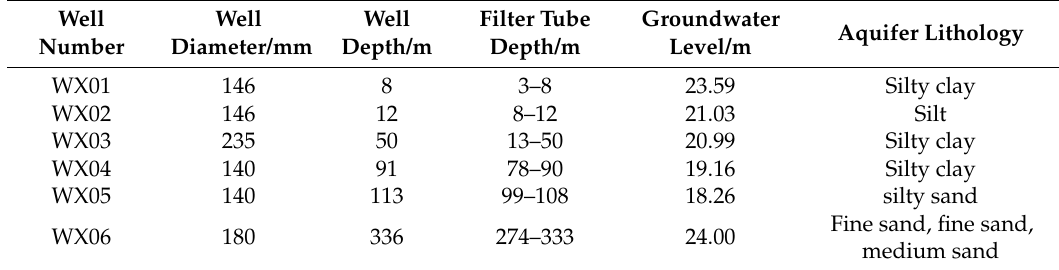
Table 1. Basic parameters of typical test